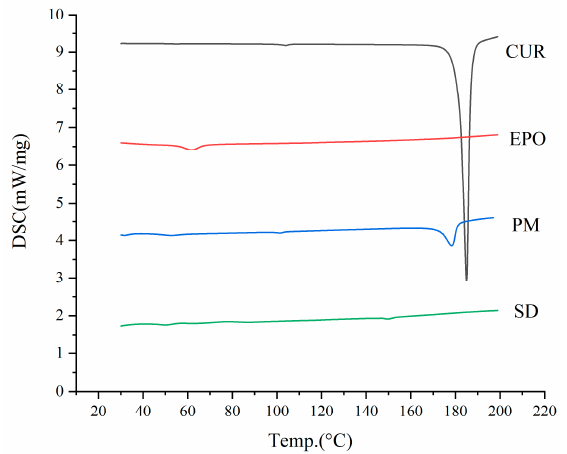
Figure 7. The DSC curves of the samples.